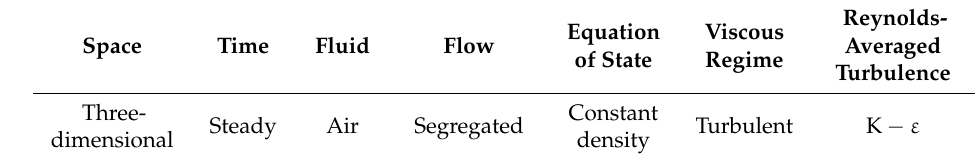
Table 3. Numerical factors of simulation conditions.